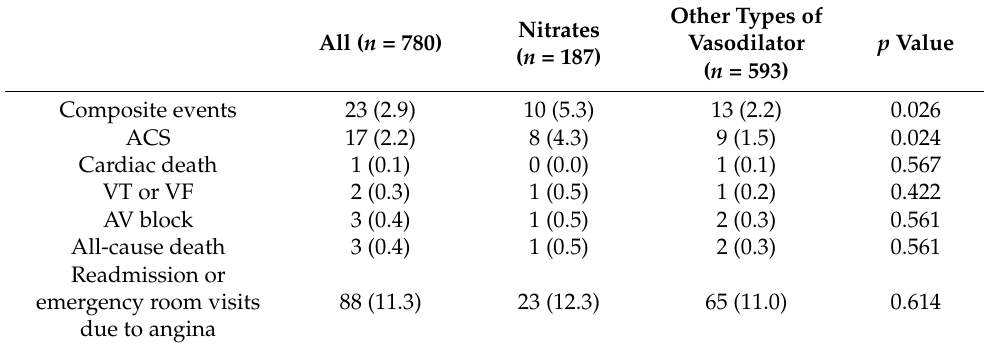
Table 2. One-year clinical event rate of patients with VA according to types of